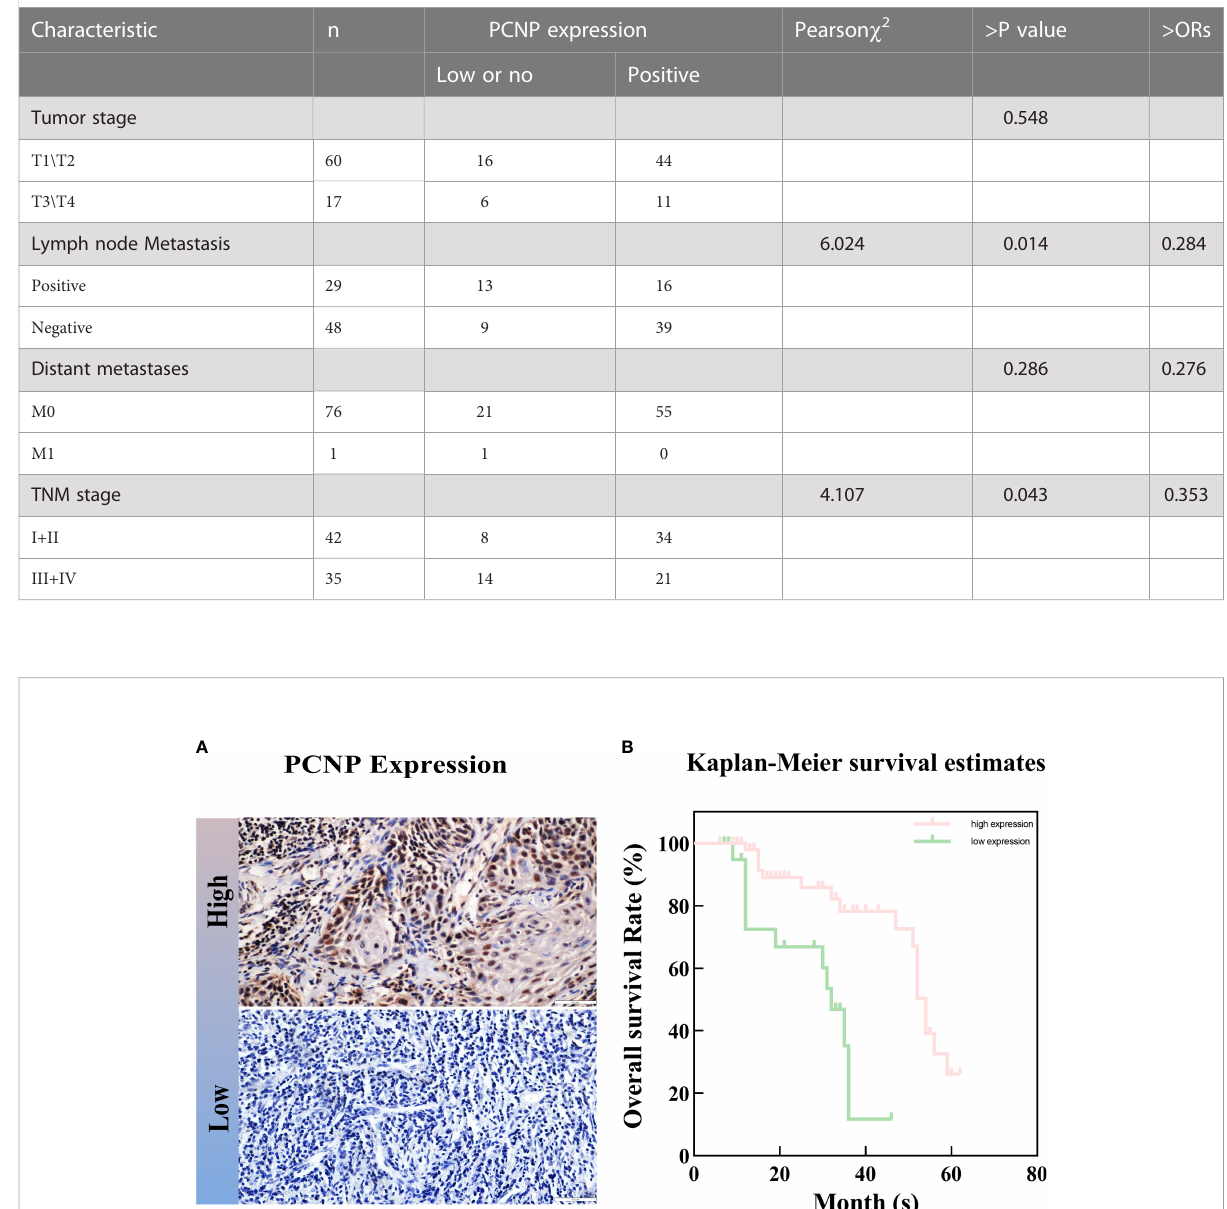
plots of force-distance curves for each group of samples are shown in Figure S1, and the distribution of stiffness in all groups of samples is demonstrated in Figure S2. The Pearson correlation coef fi cient also determined a positive correlation between PCNP protein level and OSCC tissue stiffness (R = 0.86, P < 0.001) (Figure 9), which demonstrated that as the degree of tumor differentiation increased, tissue stiffness increased accordingly.